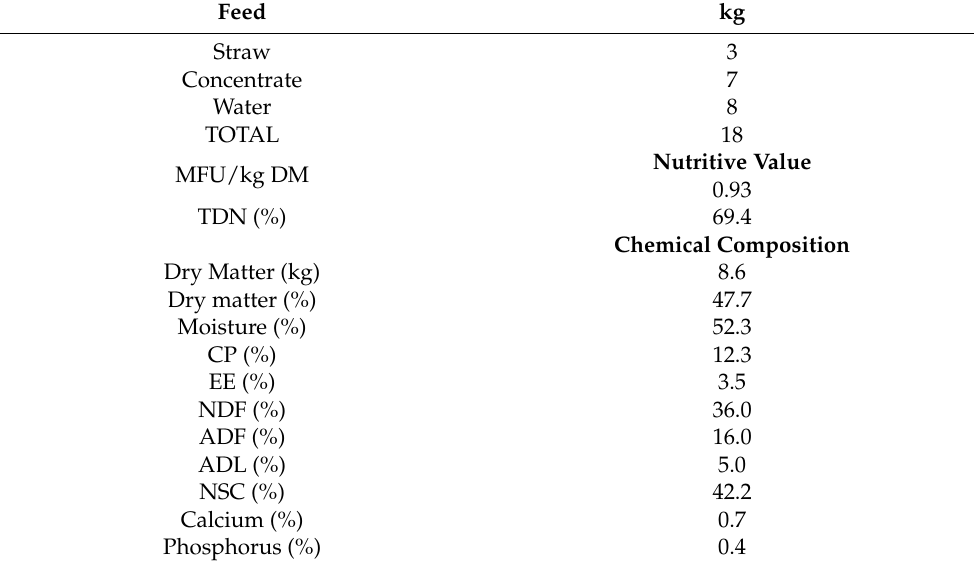
Table 1. Feed (kg) and chemical composition (% of dry matter, DM) of the diet for buffalo bulls reared at 10 and 15 m 2 /head. Feed kg Straw 3